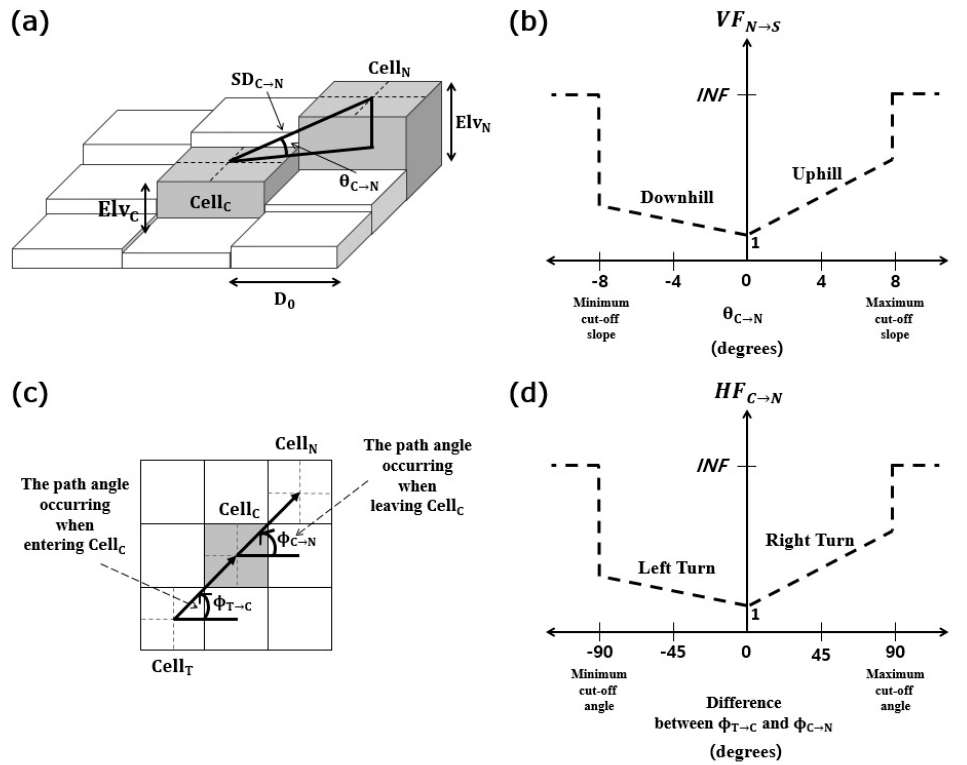
Figure 5. Concept of factors used for calculating travel cost. ( a ) Example of calculating slope gradient Fig 6. occurring when connecting the center cell (Cell C ) and a neighboring cell (Cell N ). SD C → N is the 2,5-dimensional physical distance (m) between the centers of Cell C and Cell N. Elv C (Elv N ) is the elevation (m above sea level) of Cell C (Cell N). θ C → N is the slope-gradient (degrees or percent) occurring when connecting the center of the Cell C and the center of the Cell N. D 0 is the cell size (m); ( b ) Vertical factor graph according to the slope gradient; ( c ) Example of calculating the difference between the path angle ( φ T → C ) occurring when entering Cell C and the path angle ( φ C → N ) occurring when leaving Cell C; ( d ) Horizontal factor graph according to the difference between φ T → C and φ C → N